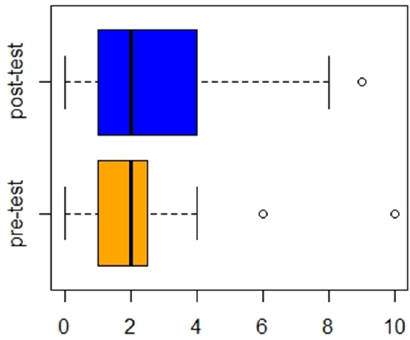
Figure 3. Boxplot graph representing the pupils’ scores in the pre- and post-test of the contextual cues intervention. Note: There was one outlier in the pre-test and two outliers in the post-test.